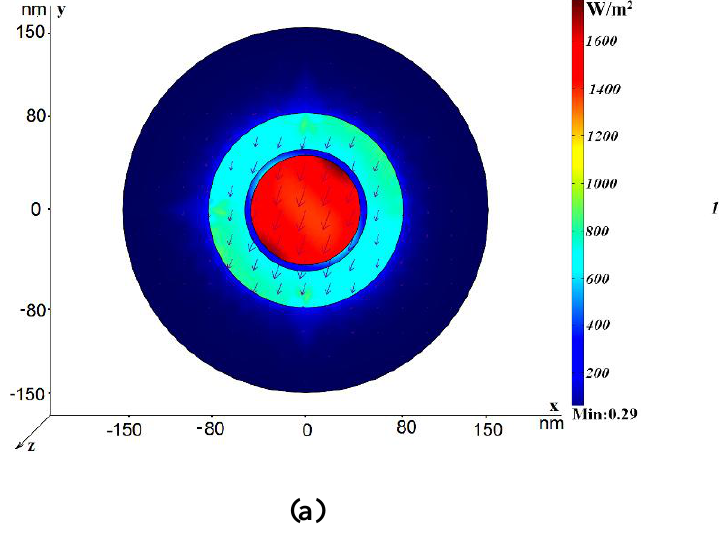
= 45 nm, h = 5 nm, in 1 = 4.32 + i 0.42, L = 0.09  eff